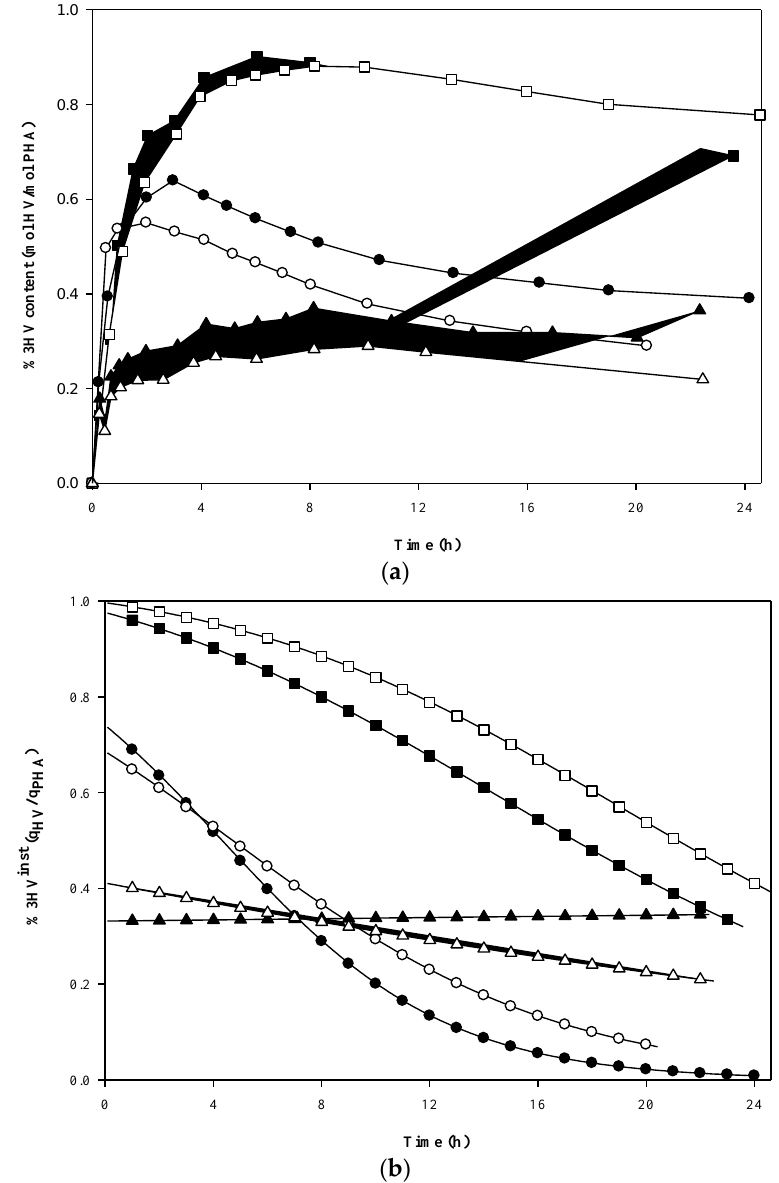
Figure 3. Evolution of 3HV fraction during PHA accumulation using different feeding strategies: ( a ) accumulated 3HV fraction; and ( b ) instantaneous 3HV fraction calculated from data regression. Experiment set 2: 100% propionic acid ( ■ , Exp 2; and □ , Exp 2′). Experiment set 3: 50% acetic acid and 50% propionic acid fed simultaneously (●, Exp 3; and ○ , Exp 3′). Experiment set 4: 100% acetic acid alternating with 100% propionic acid ( ▲ , Exp 4; and ∆, Exp 4′).